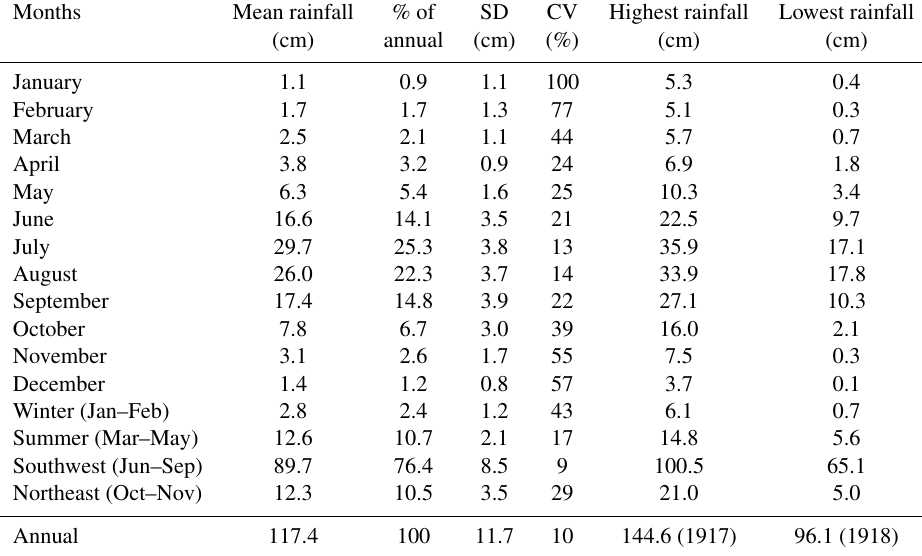
Table 1. Rainwater statistics of the contiguous Indian area-1901 to 1960 (Dhar and Rakhecha, 1975, 1979). Months